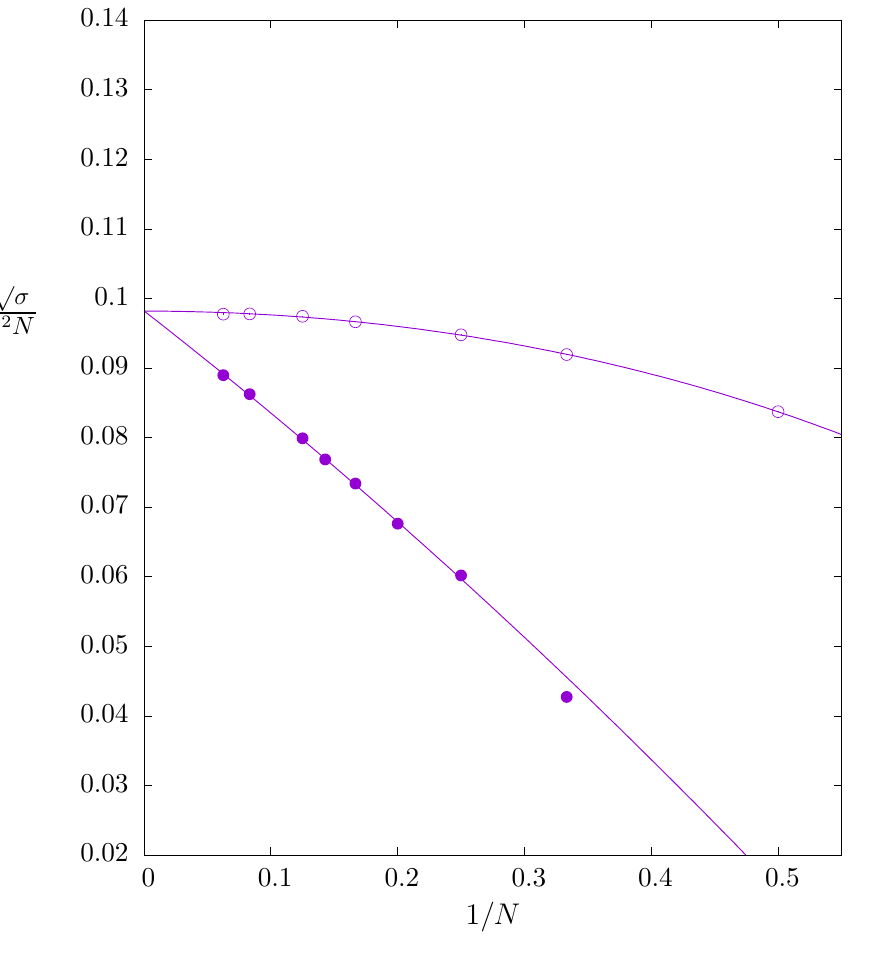
p (cid:27)=g 2 N in SO( N ), (cid:15) , with extrapolation to N = 1 as in p (cid:27)= 2 g 2 N , (cid:14) , with the large N (cid:12)t given in eq.